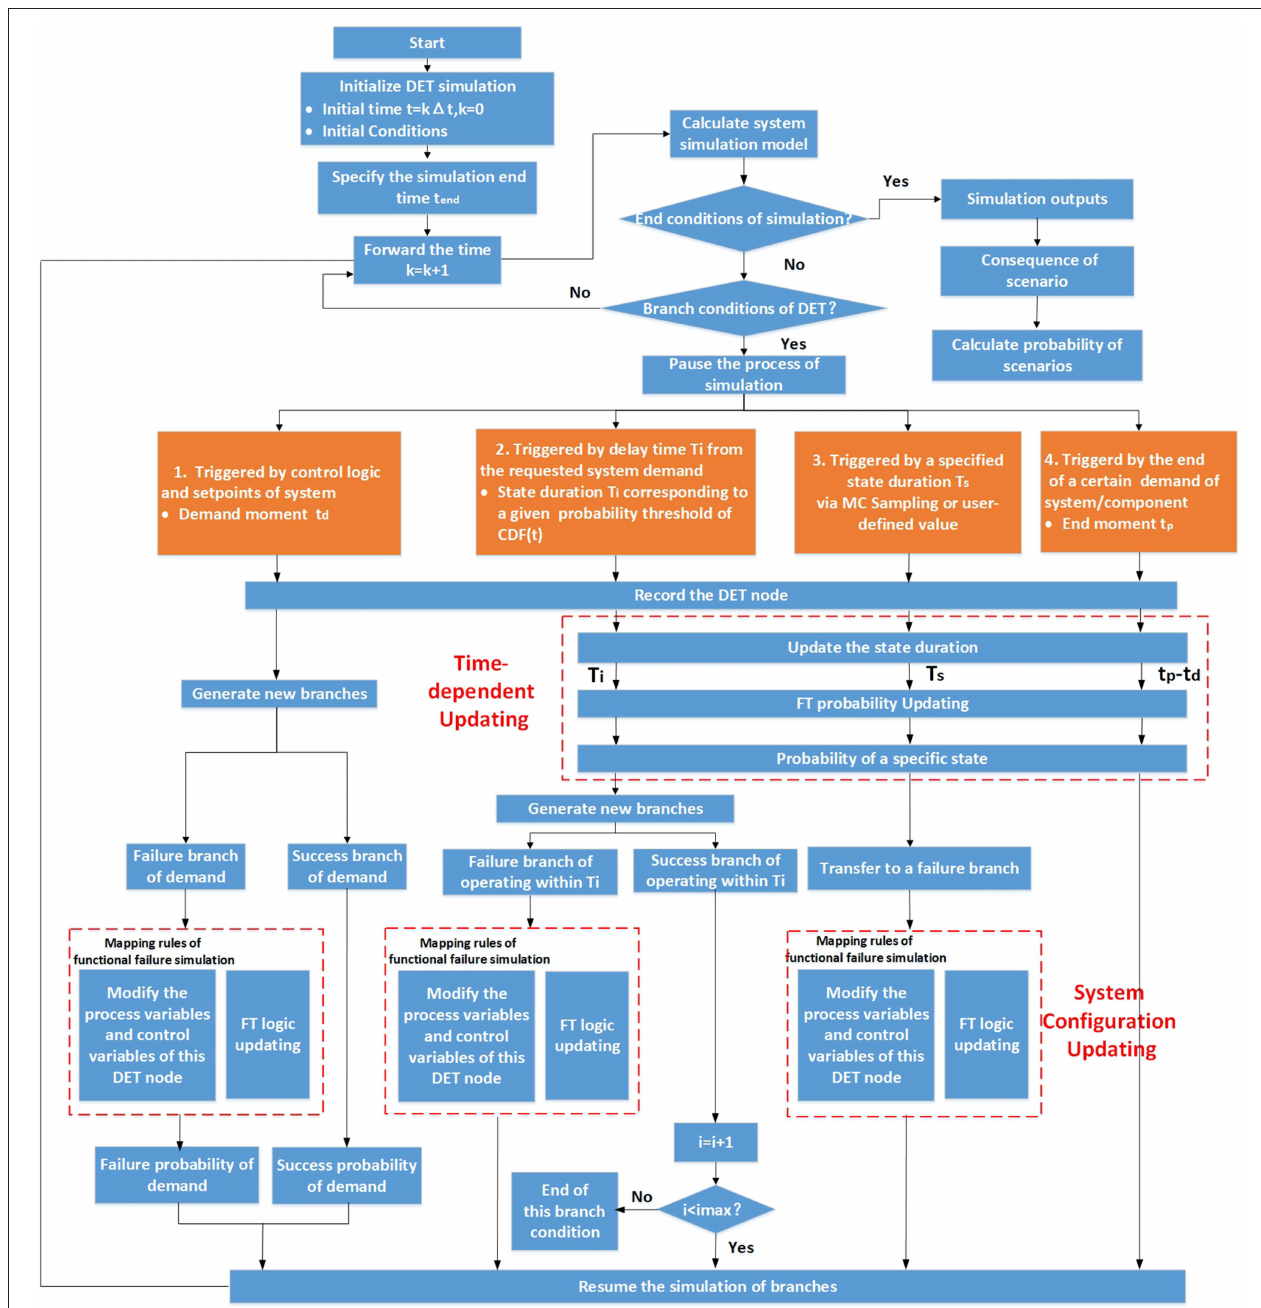
FIGURE 5 | Flow graph of DDET simulation coupled with